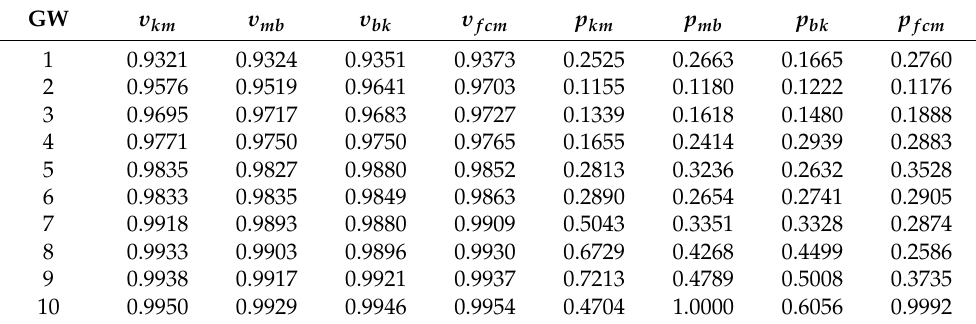
Table 3. ULDR and p -values obtained from the application of each clustering method for the different number of GWs (Scenario 1).